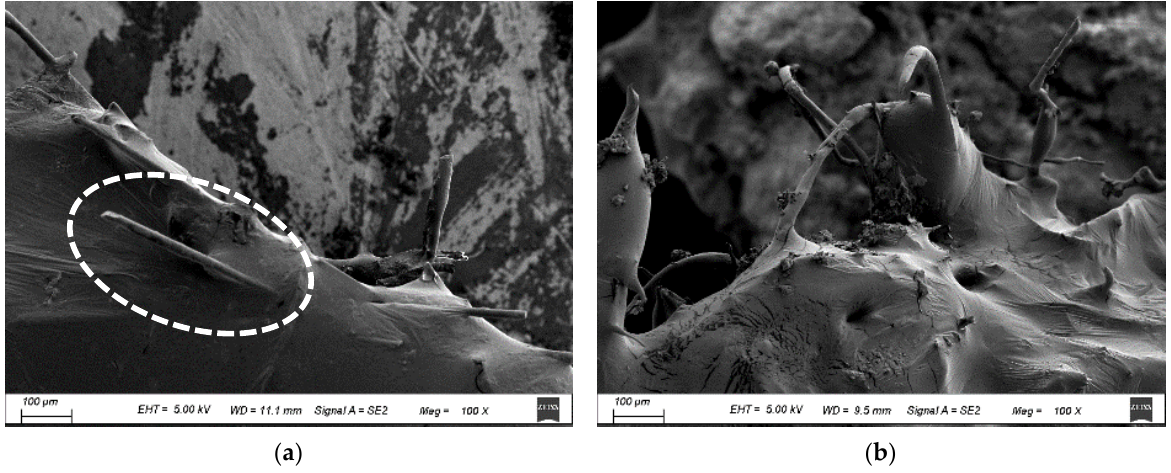
Figure 10. SEM images of fiber reinforced mixtures: ( a ) BFSMA-13; ( b ) LFSMA-13.